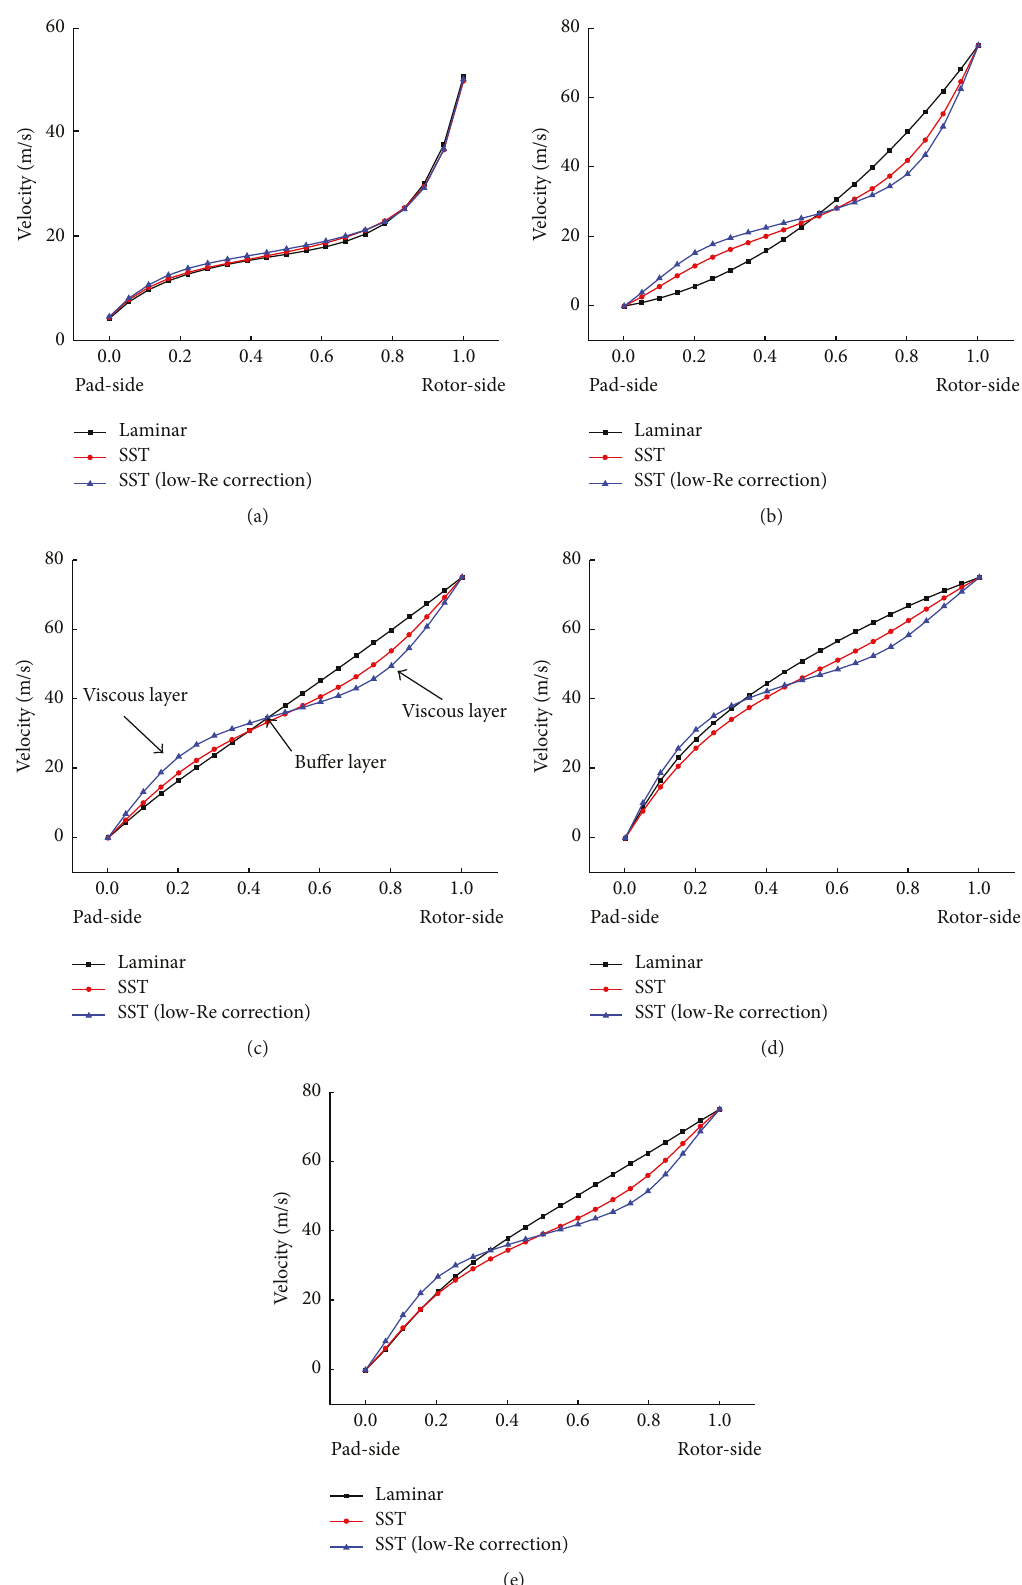
Figure 13: Velocity profiles in the middle plane. (a) In 0 ∘ from the inlet; (b) in 20 ∘ from the inlet; (c) in 40 ∘ from the inlet; (d) in 60 ∘ from the inlet; and (e) in 80 ∘ from the